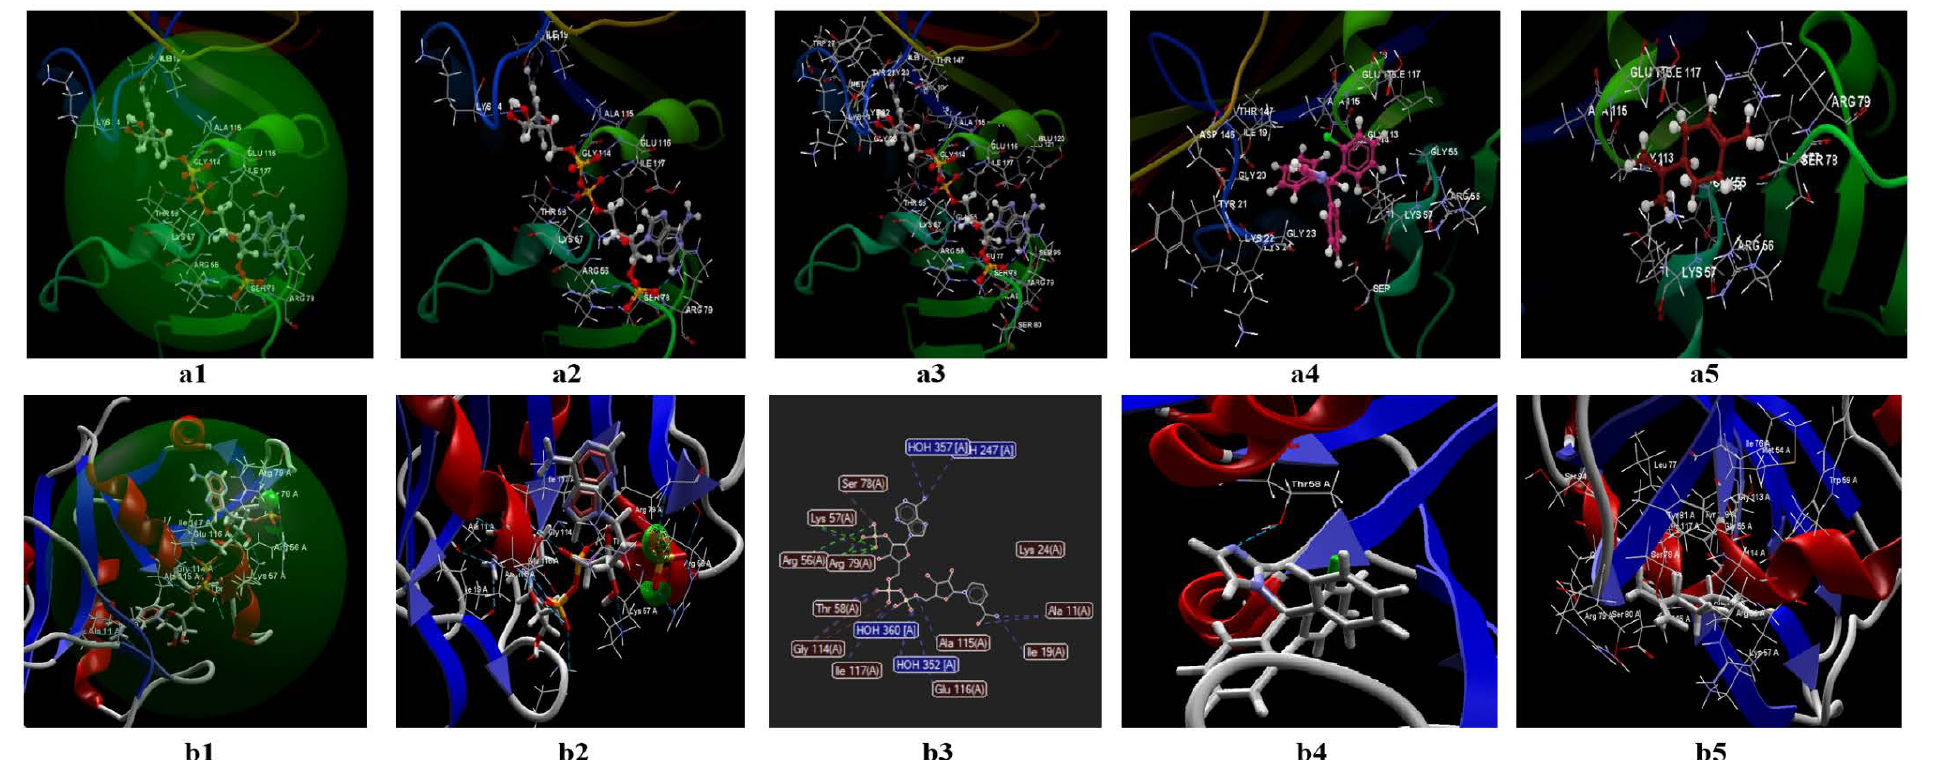
Figure 8. Molecular docking of the co-crystallized (NDP), limonene, and clotrimazole for C. albicans in the binding site 1AI9. ( a1 ) Co-crystallized NDP (score: − 79.35; RMSD 2.86) in the binding site (model generated by CLC); ( b1 ) the co-crystallized NDP (score: − 155.24; RMSD 0.00) in the binding site (model generated with MOLEGRO); ( a2 ) hydrogen bonds of the co-crystallized NDP in the binding site, generated by CLC; ( b2 ) hydrogen bonds, electrostatic interactions, steric interactions between the co-crystallized NDP and amino acids in 3D, generated by MOLEGRO; ( a3 ) the interaction of co-crystallized NDP with amino acids’ residues in binding site, generated by CLC; ( b3 ) hydrogen bonds (blue), electrostatic interactions (green), steric interactions (red) between the co-crystallized NDP and amino acids in 2D, generated by MOLEGRO; ( a4 ) the interaction of clotrimazole with the amino acid residues from the binding site (model generated by CLC); ( b4 ) the interactions of clotrimazole and the hydrogen bonds (blue line) with THR 58 amino acid in the binding site (model generated by MOLEGRO); ( a5 ) the interaction of limonene with the amino acid residues from the binding site in a model generated with CLC; ( b5 ) the interaction of limonene with the amino acid residues from the binding the site (model generated by MOLEGRO).